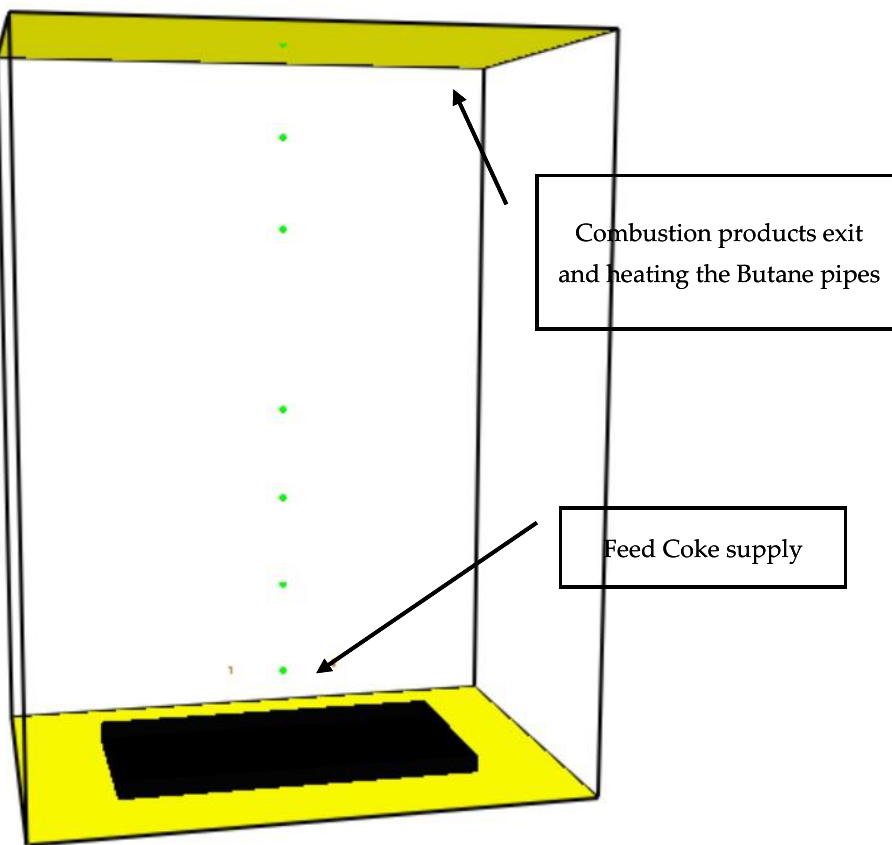
Figure 2. Geometrical model of the pet-coke burner.